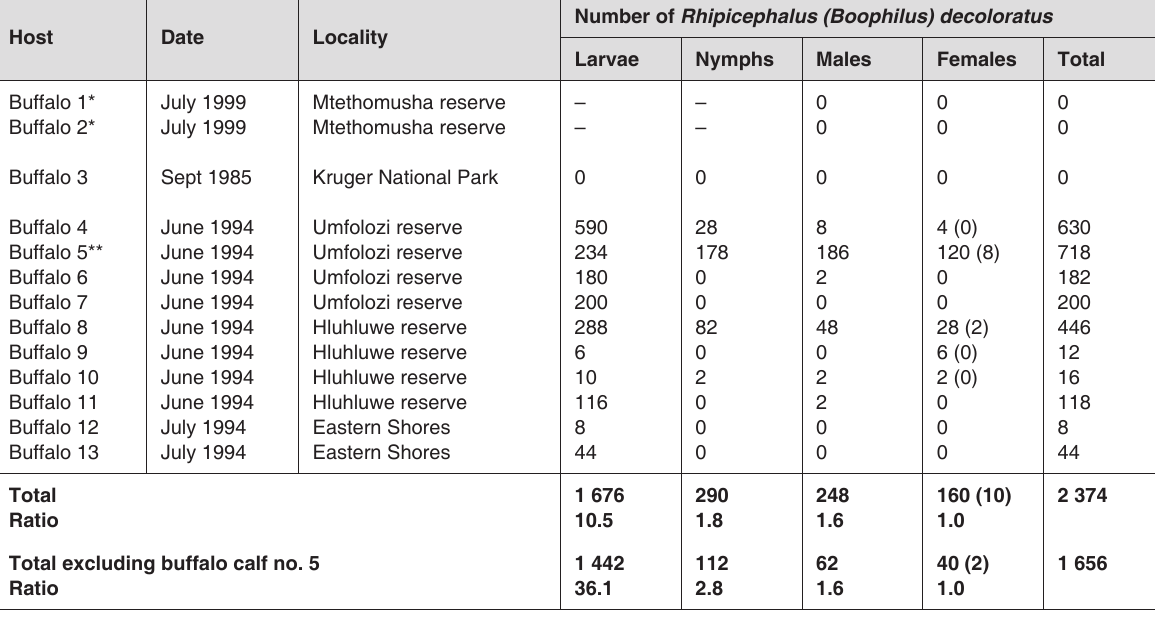
TABLE 1 Numbers of Rhipicephalus (Boophilus) decoloratus collected from African buffaloes in five nature reserves in South